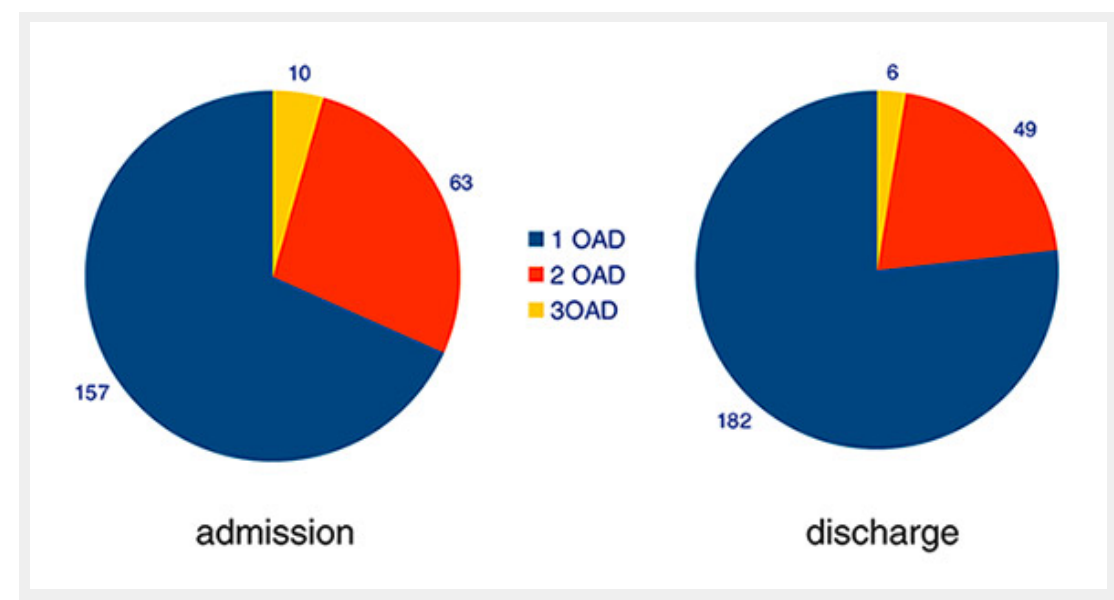
Figure 3 Therapy with oral antidiabetic drugs (OADs) in patients from group A. Figures indicate absolute numbers of patients treated with one, two or three